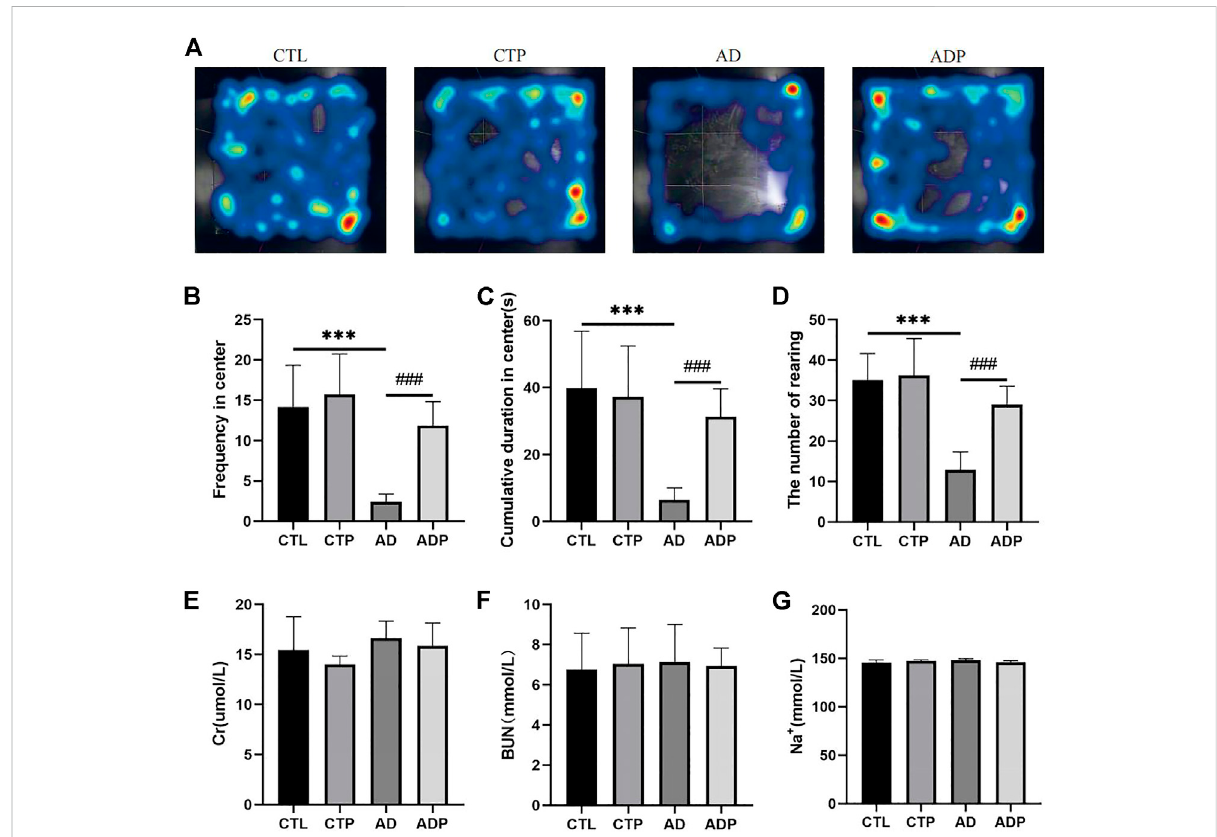
FIGURE 1 Behavioral measurements. (A) Typical images of trajectory after empty bottle stimulation. (B) Frequency of central entries. (C) Cumulative time incenter. (D) Numberofrearing.n=15pergroup. (E – G) Theconcentrationofcreatinine(Cr),ureanitrogen(BUN)andNa + inserum.* p < 0.05,** p